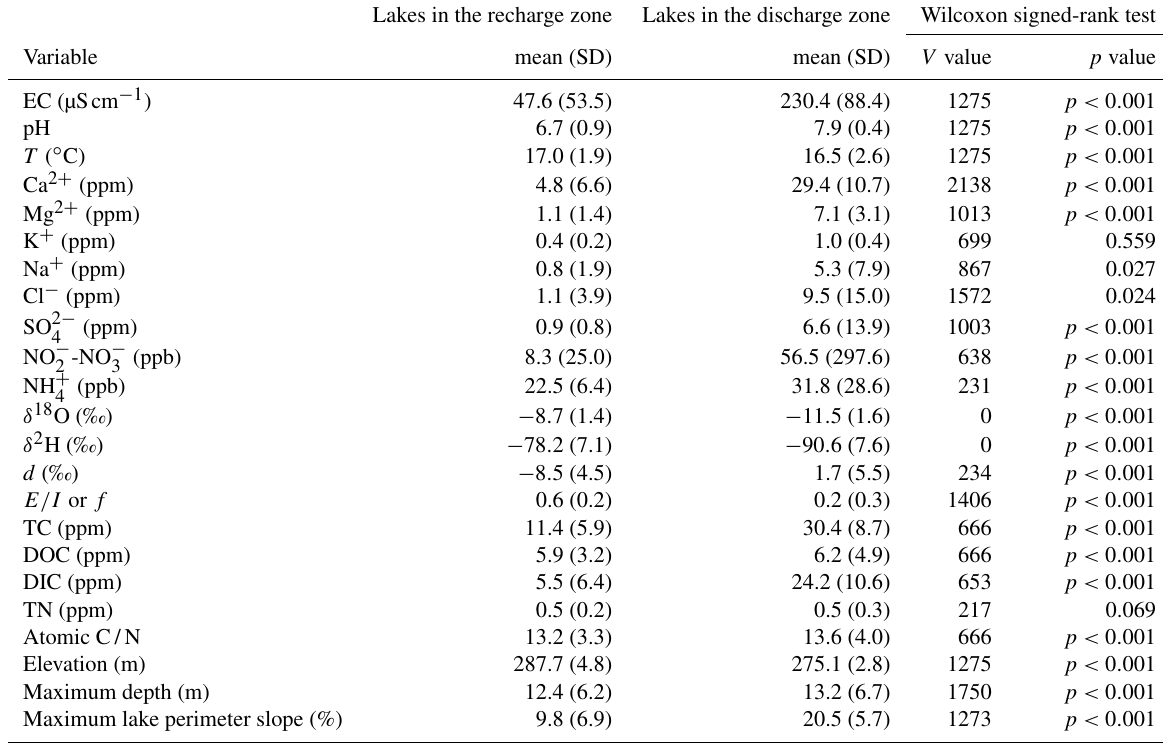
Table A2. Results of the Wilcoxon signed-rank test of individual conservative and non-conservative hydrological tracers using the two-class lake typology as the categorical variable. Non-significant p values are indicated in bold. Lakes in the recharge zone are defined as lakes above an elevation of 282ma.s.l., whereas lakes in the discharge zone are defined as lakes located at an elevation of less than 282ma.s.l. Lakes in the recharge zone Lakes in the discharge